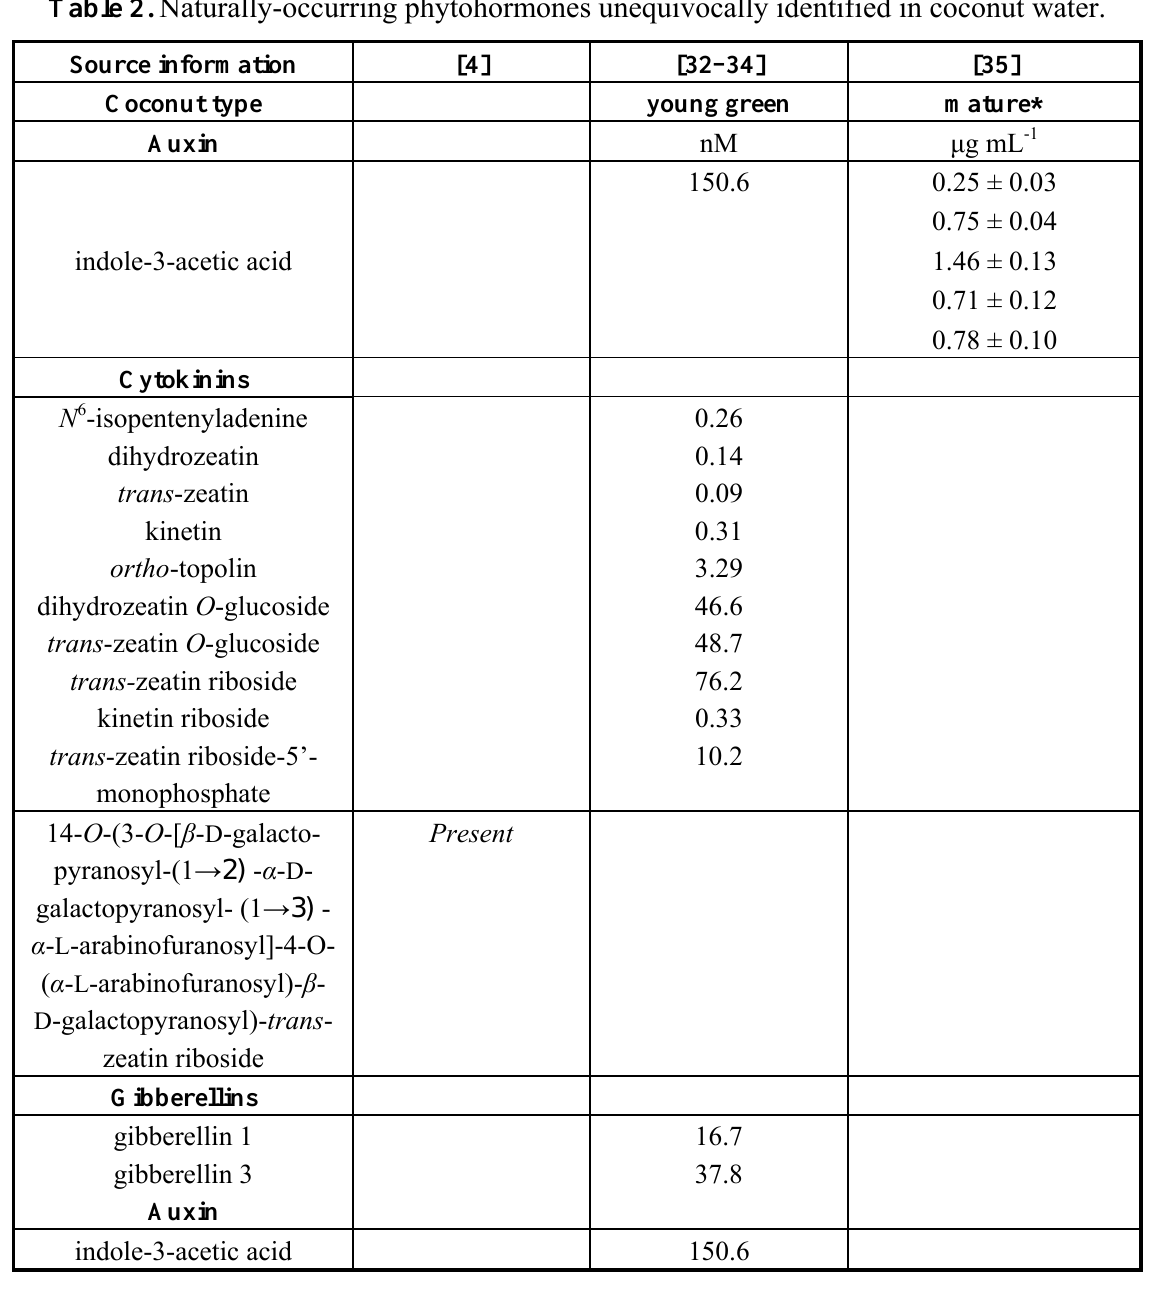
Table 2. Naturally-occurring phytohormones unequivocally identified in coconut